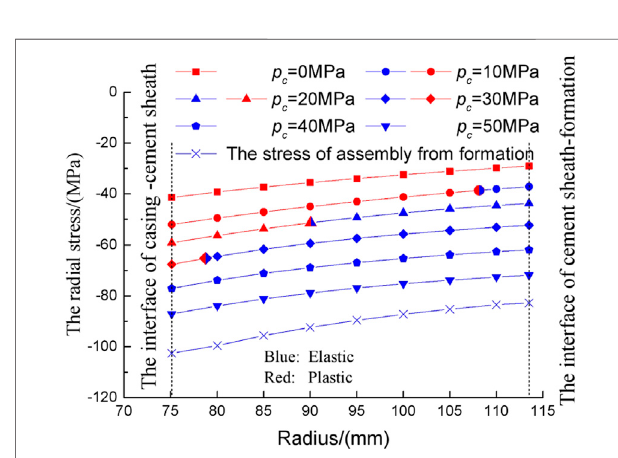
FIGURE 5 | Radial stress distribution of the cement sheath on a casing pressure of 150